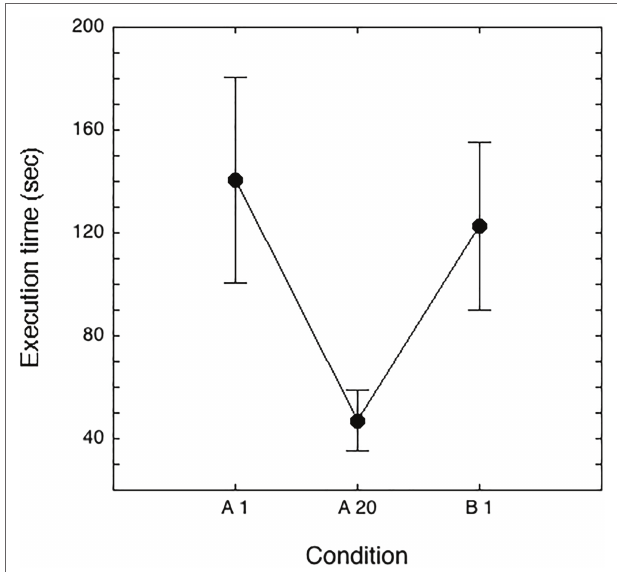
FIGURE 4 | Mean time spent (seconds) and SDs in the experimental test in the A1 and A20 matrices, containing the same stimuli, and in the B1 matrix, containing new